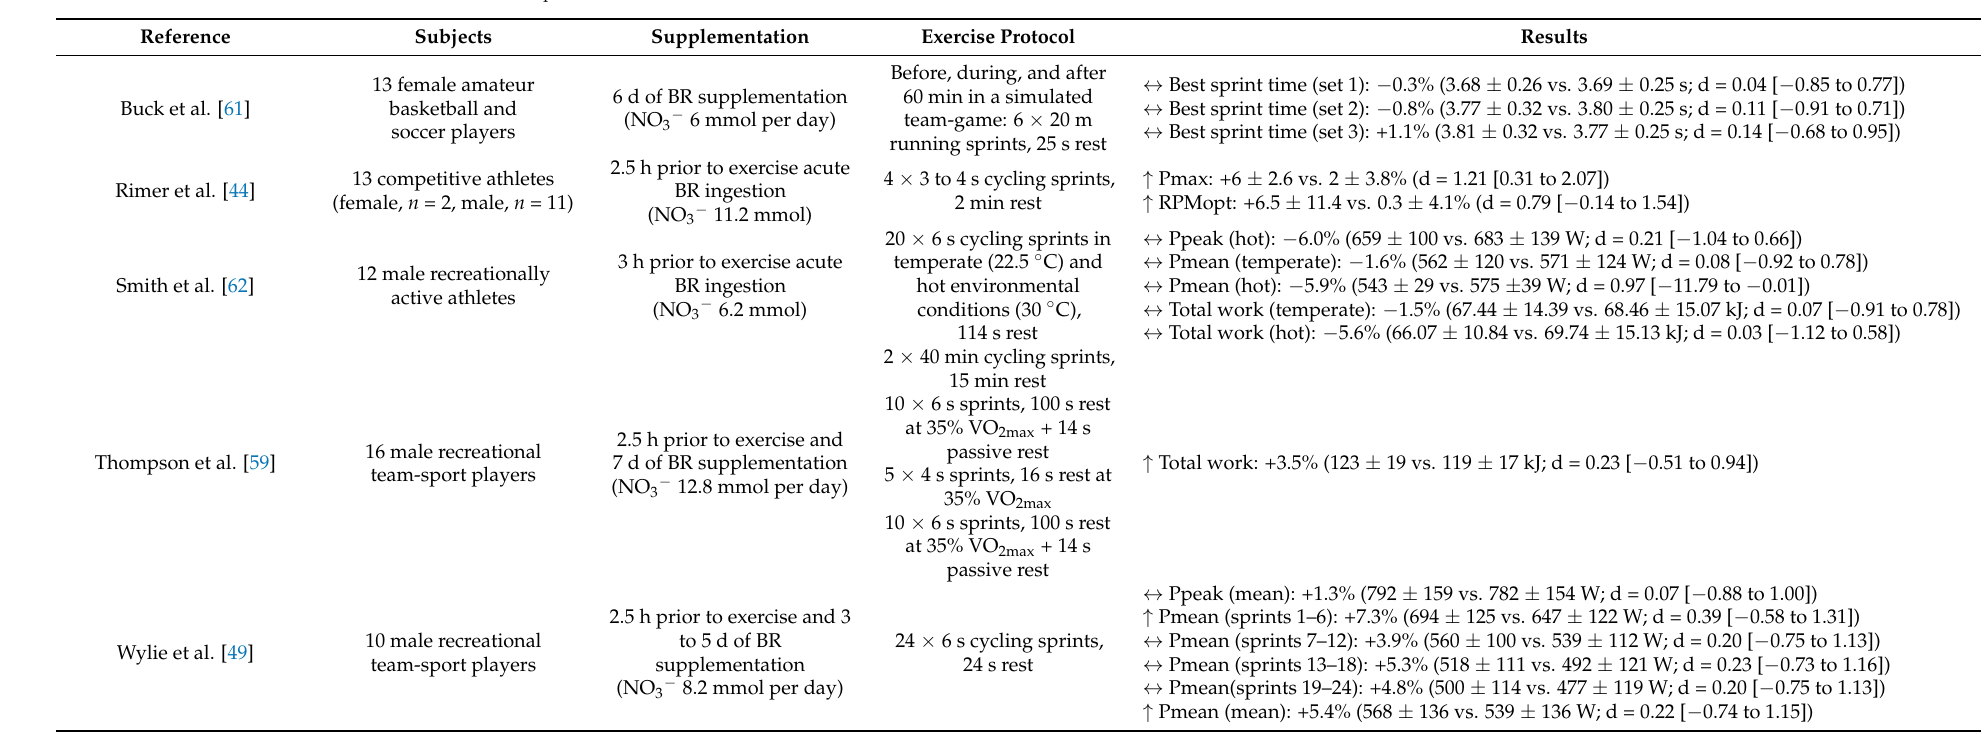
Table 2. Description of studies that have investigated the effects of dietary NO 3 − supplementation on high-intensity, sprint-type explosive efforts in humans.